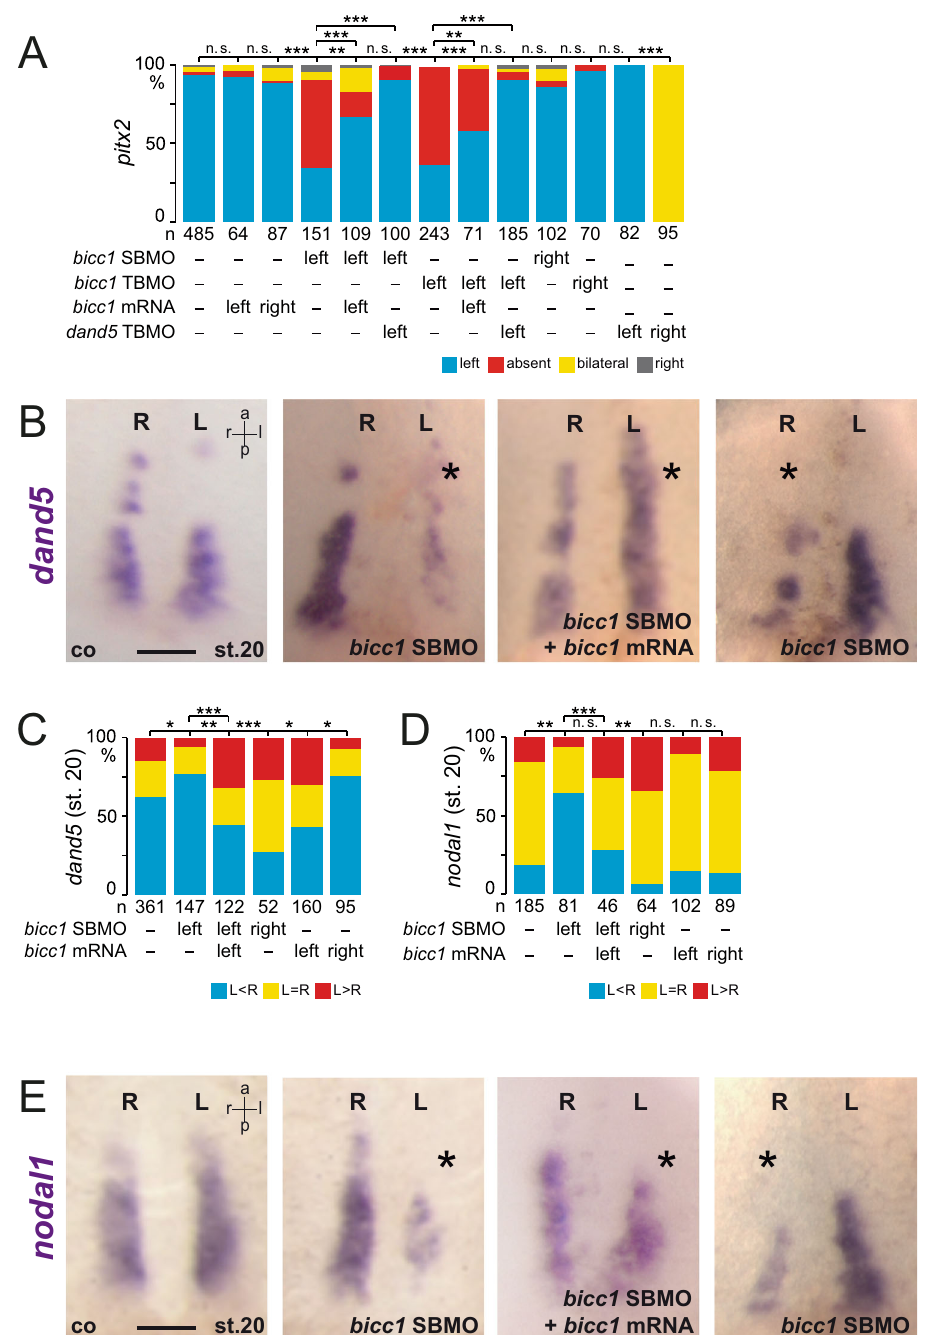
Fig. 3 Bicc1-dependent dand5 and nodal1 expression in sLRO cells. A Absence of left LPM pitx2 expression in bicc1 morphants, unilaterally injected on the left, was rescued by parallel knockdown of dand5 . Speci fi city of TBMO or SBMO was shown by co-injecting rescue mRNAs, i.e., mouse bicc1 or Xenopus bicc1 , respectively. Note dand5 knockdown on the right ef fi ciently induced pitx2 expression, as published. B Loss of dand5 mRNA at post- fl ow stages (st. 20) following left- and right-sided bicc1 SBMO injections. Controls (co) showed wt expression. dand5 expression was restored by co-injecting bicc1 rescue mRNA. Note enhanced dand5 staining in rescued specimens. C Quanti fi cation of dand5 expression after knockdown of bicc1 . The effect was observed in the left and right sLRO cells. D , E Downregulation of nodal1 in bicc1 morphants. D Quanti fi cation of results. E Wt specimens show bilateral nodal1 mRNA. Left or right bicc1 SBMO injections reduced nodal1 , which was restored by adding rescue bicc1 mRNA. MO pmol/embryo: bicc1 SBMO (L and S, each 1); bicc1 TBMO, (L and S, each 1); dand5 TPMO (0.5). Asterisks in B and E mark the injected side. Numbers (n) in A , C , and D represent analyzed specimens from more than three independent experiments. Statistical analyses were done with one-sided Pearson ’ s chi-square test, which was adjusted for multiple comparisons by Bonferroni ( B ) or Bonferroni – Holm ( C , D ). n.s. not signi fi cant p > 0.05; * signi fi cant, p < 0.05; ** highly signi fi cant p < 0.01; ***, very highly signi fi cant p < 0.001. p values and listing of individual experiments can be found in the source data fi le. st., stage. Scale bars in B and E represent 100 µ m. st. stage, a anterior, l left, r right, p